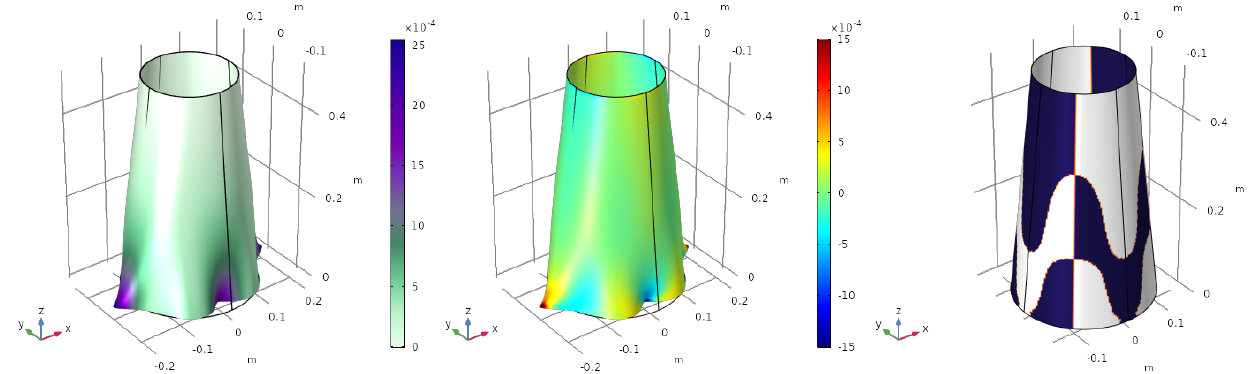
Figure 3. Second load case. Deformation of the structure ( left ), electric charge ( centre ) and optimized electrode profile ( right